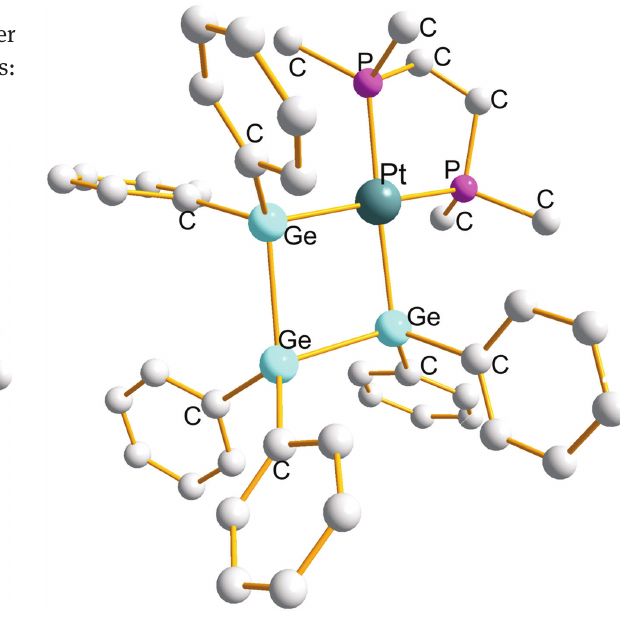
Figure 1: Structure of cis-[Pt{η 2 -(Ph)(Me)P(C (Me)As(CH